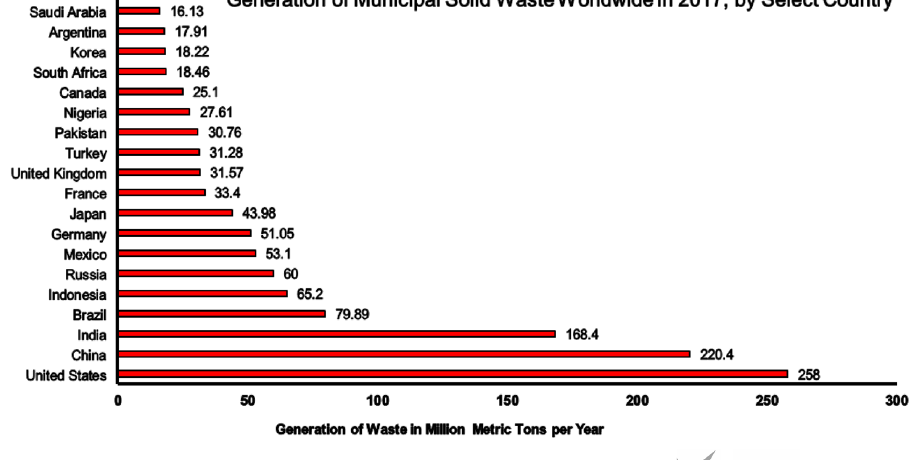
Fig. 5 Generation of municipal solid waste worldwide in 2017 Recreated After World